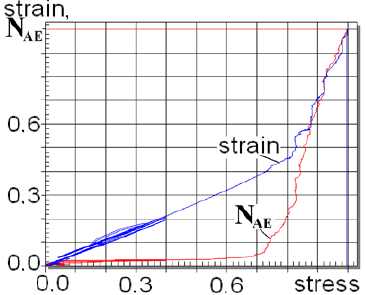
Figure 4. The dependence of the total acoustic emission and deformation on the stress of the sample with a transverse arrangement of fibres with three times training, corresponding to 40% of the breaking load (sample width 20